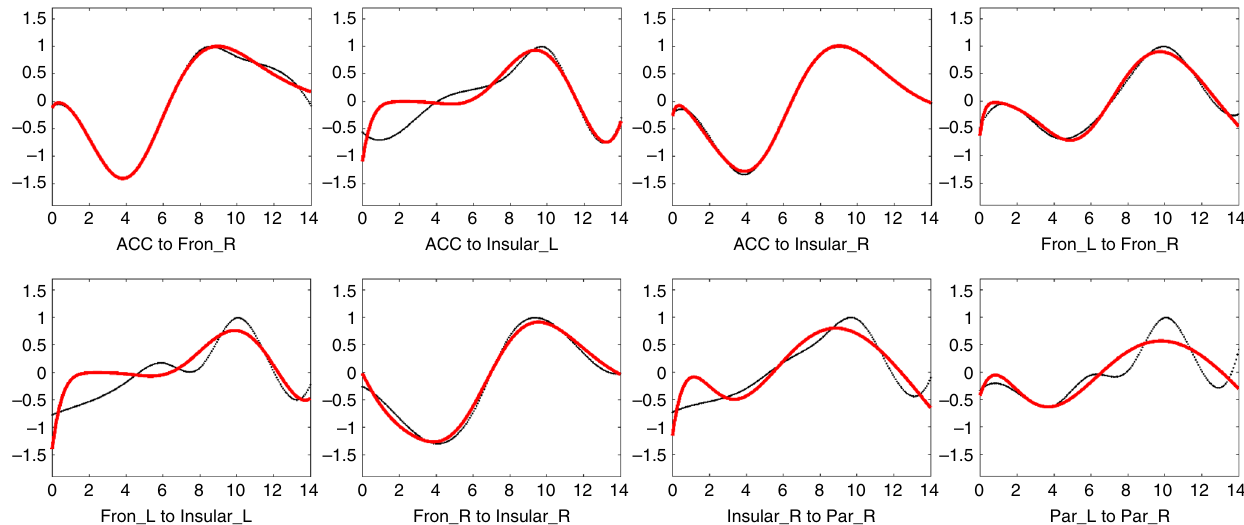
Fig. 6 Fitting of the average time course of eight selected tracts. The x -axis is the time (seconds), y -axis is the signal intensity (a.u.). The black curves represent the average time courses. The red curves represent the fi tting curves. Source data are provided as a Source Data fi